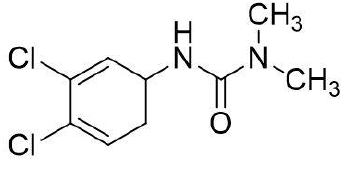
Figure 1. Diuron chemical structure.